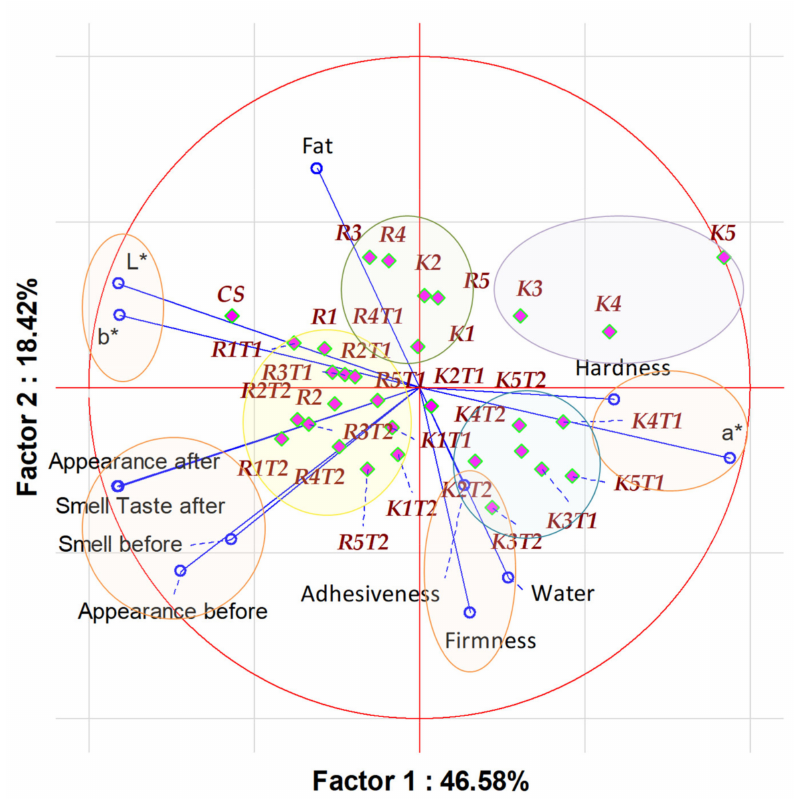
Figure 9. Principal component analysis (PCA) of the following samples: CS-control sample, R1–R5-CS with rice protein (from 1% to 5%, respectively), R1T1–R5T1-CS with 1% TGase and rice protein (from 1% to 5%, respectively), R1T2-R5T2-CS with 2% TGase and rice protein (from 1% to 5%, respectively), K1–K5-CS with hemp protein (from 1% to 5%, respectively), K1T1–K5T1-CS with 1% TGase and hemp protein (from 1% to 5%, respectively), K1T2–K5T2-CS with 2% TGase and hemp protein (from 1% to 5%, respectively). L*, b* and a* correspond to color components, ‘before’ and ‘after’ correspond to parameters measured before and after